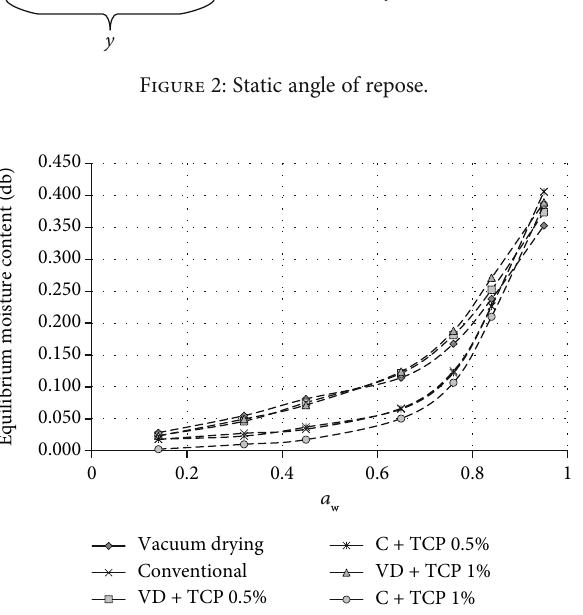
Figure 3: Water sorption isotherm of conventional and vacuum- dried coconut sugar (VD=vacuum drying, C=conventional). Table 1: Estimated GAB parameters of coconut sugar powder produced by the conventional method and the drying methods.